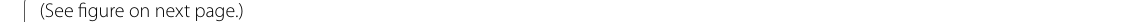
figure on next Fig. 3 Phylogenetic trees of identified isolates of Trichoderma , constructed by the analysis of ITS1 sequences with neighbor joining algorithm in MEGA 6X package. The numbers over branches represent the coefficient of bootstrap, tested by 100 replications. a Isolate 1006, identified as Trichoderma atroviride (accession no. MW590689); b Isolate 1007, identified as Trichoderma harzianum (accession no. MW590687); c Isolate 1013, identified as Trichoderma longibrachiatum (accession no. MW590688). A red dot in each figure represents the highest similarity of identified isolates based on the sequences available in